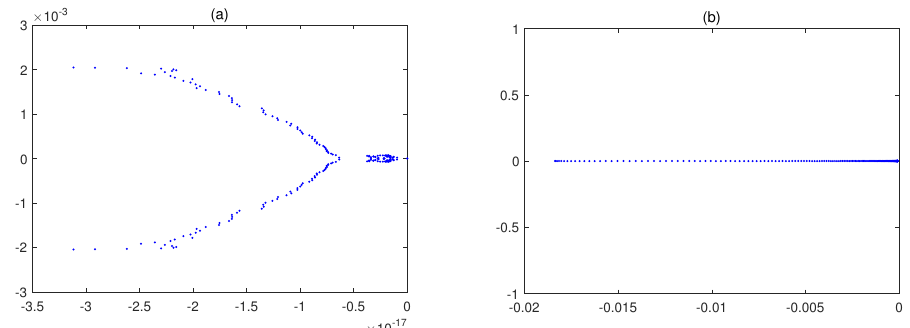
Figure 5. The eigenvalues of A ( a ) and B ( b ) for N = 1000, n i = 589 and c = 1.08 in Example 1. Table 3. The L ∞ , L 2 and RMS errors with τ = 0.01, N = 900 and n i = 489 for Example 2.